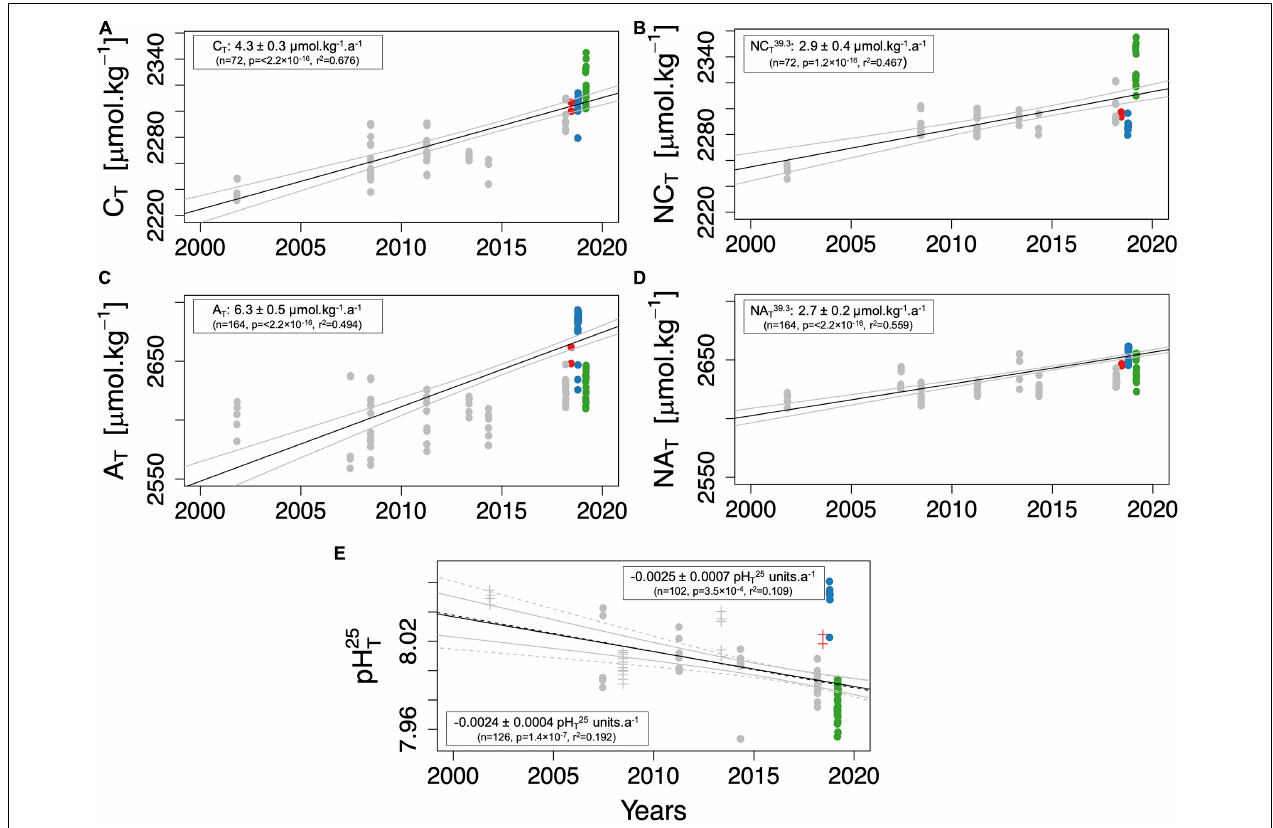
FIGURE 8 | Temporal evolution in the North Western Levantine Basin of total dissolved inorganic carbon (C T – µ mol.kg − 1 ; A ) and salinity-normalised C T (NC T 39 . 3 – µ mol.kg − 1 ; B ), total alkalinity (A T – µ mol.kg − 1 ; C ) and salinity-normalised A T (NA T 39 . 3 – µ mol.kg − 1 ; D ) and pH T 25 (E) based on the CARIMED dataset (grey dots) and PERLE cruises. The colour code for the dots is the same as in Figure 1 . Only data above 50 dbars are used. In (E) , full line and dashed lines correspond to the temporal trends calculated according to all pH T 25 data [measured (full dots—trend framed in full lines) and calculated (crosses—trend framed in dotted lines)]. Estimated trends are obtained from slope values of a linear regression between the studied parameters and time. The confident interval has been added for each trend with the coefficient of determination (r 2 ), the number of values used (n) and the significance of the trend ( p -value).